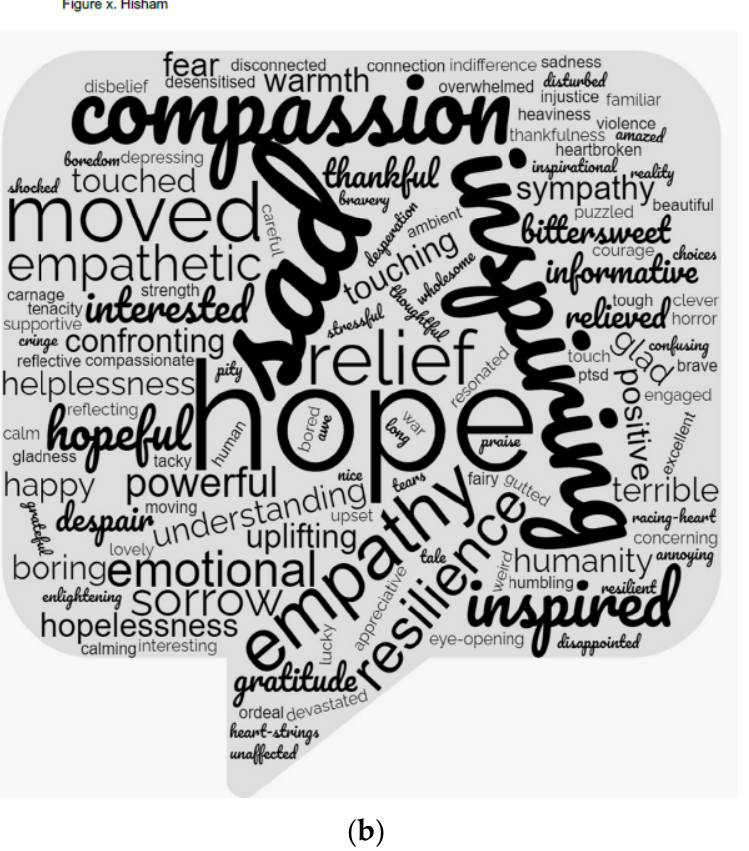
Figure 1. In one word, describe your immediate reaction to the film ( a ) Immediate reaction in one word to Refugee short film; ( b ) Immediate reaction in one word to Mental Health short